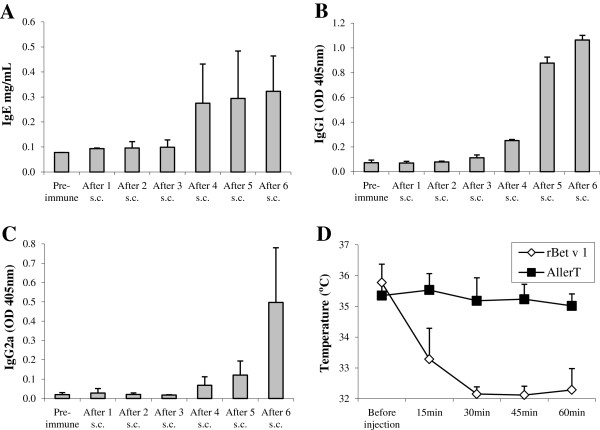
BALB/c mice sensitization and in vivo challenge. Mice were sensitized to rBet v 1 by injecting 0.1 μg rBet v 1 adsorbed to 1 mg Aluminum hydroxide. rBet v 1-specific IgE (panel A), IgG1 (panel B) and IgG2a (panel C) were measured in mice serum harvested immediately before the next injection. Results were expressed as means ± SD. Panel D. Rectal temperature was recorded at indicated time points following 30 μg rBet v 1(◊) or 190 μg AllerT (■) i.p. challenge at day 84 of the immunization protocol.